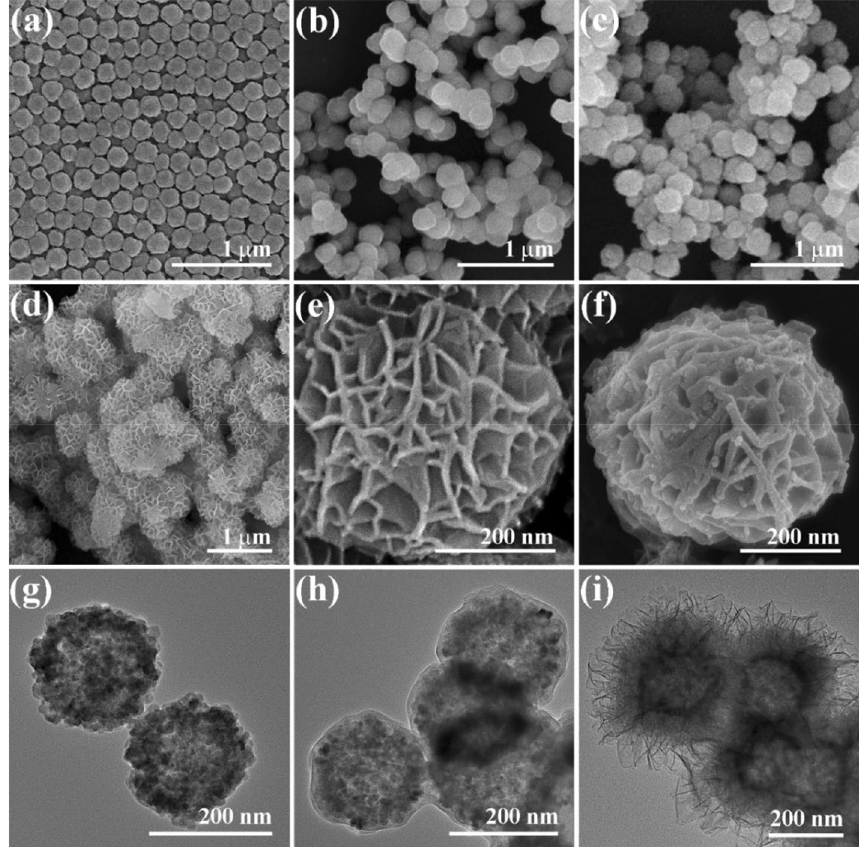
3 O 4 /C/MnO 2 flower-like microspheres ( d , e ), and Fe 3 O 4 /C/MnO 2 /C 3 N 4 flower-like microspheres ( f ), TEM images of hollow Fe 3 O 4 microspheres ( g ), Fe 3 O 4 /C core–shell microspheres ( h ) and flower-like Fe 3 O 4 /C/MnO 2 /C 3 N 4 microspheres ( i